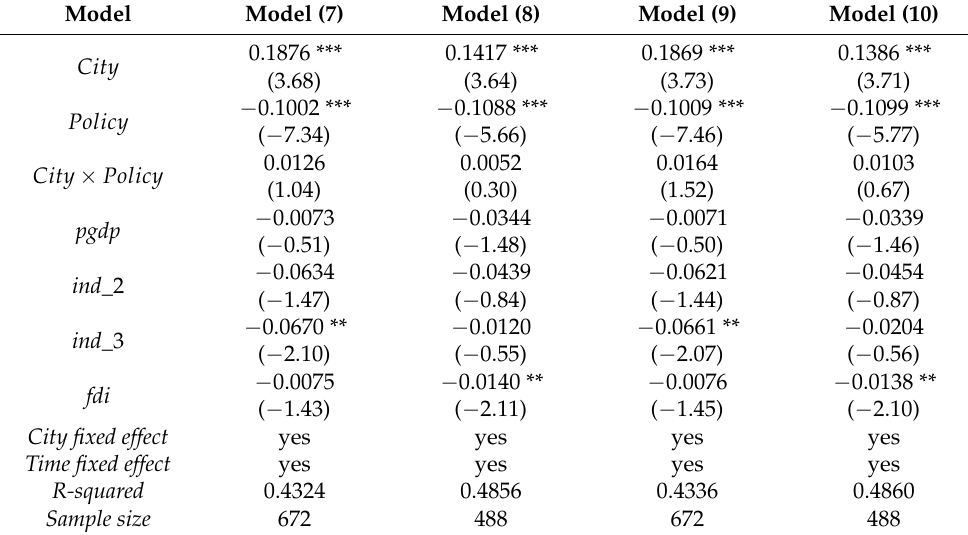
Table 3. Counterfactual test